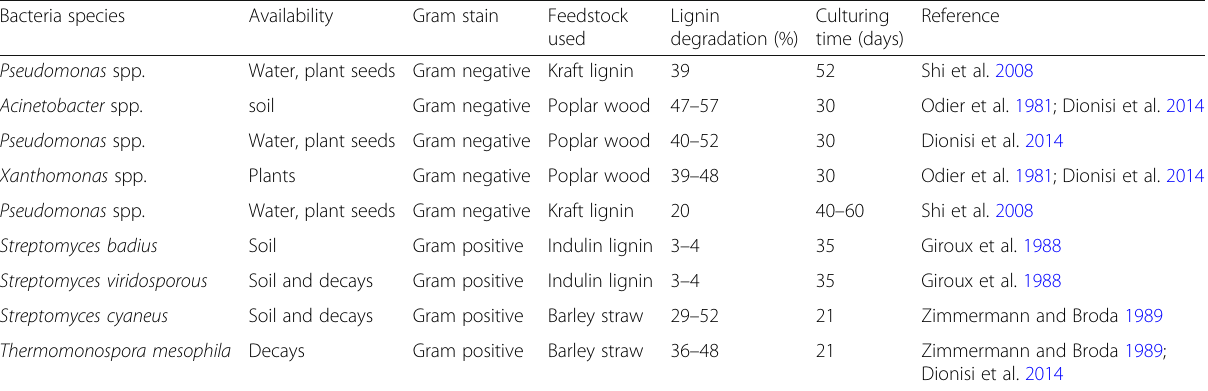
Lignin Culturing Reference used degradation (%) time (days)